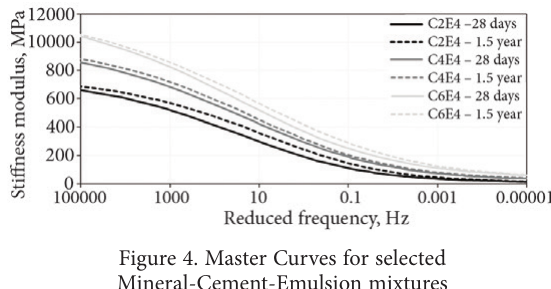
Figure 4. Master Curves for